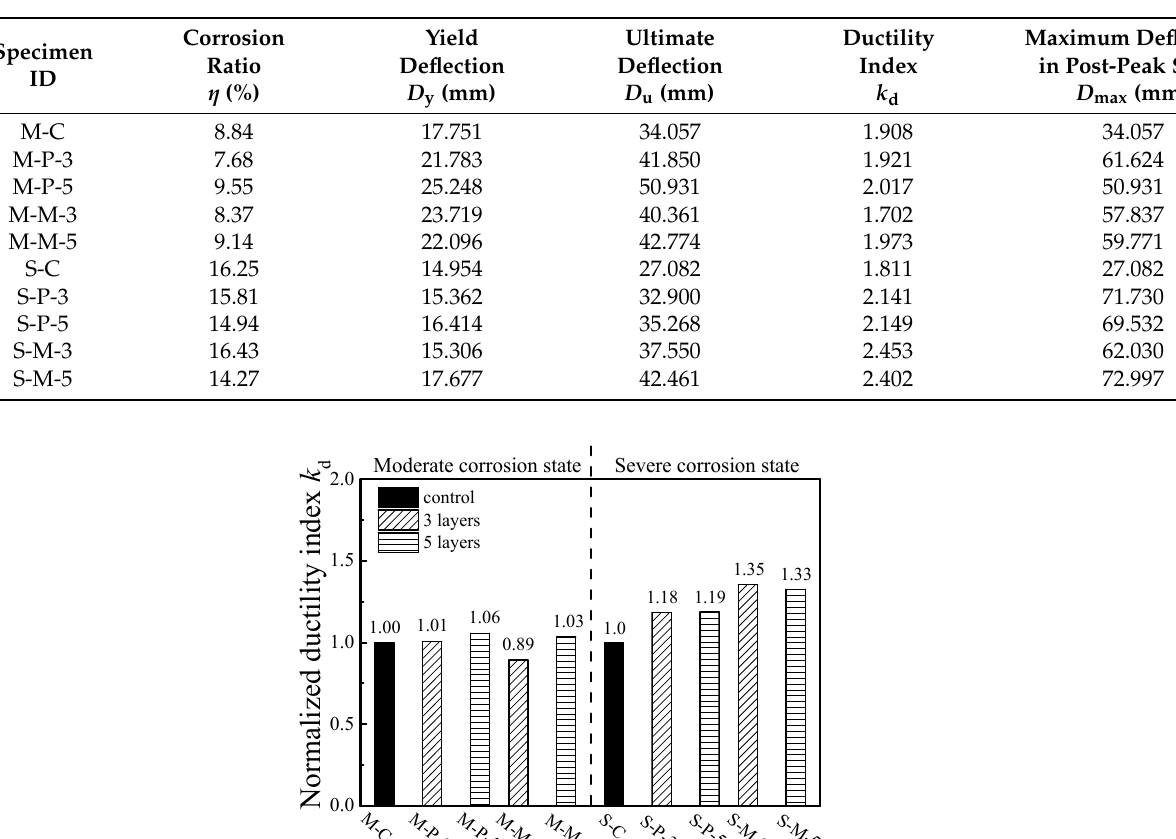
Table 7. The deflections and ductility index of specimens.